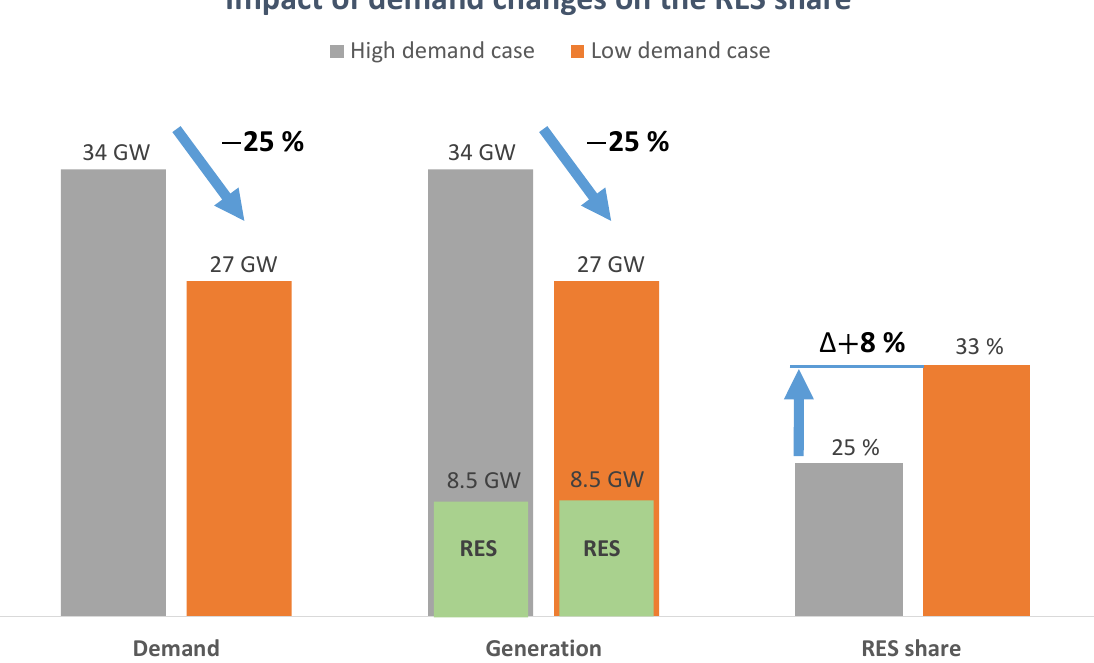
Figure 7. An illustrative example of the impact of demand changes on the renewable energy sources (RES) share for typical UK RES conditions. The RES share grows under the assumption of constant RES output before and after the demand changes. The RES shares are kept constant in order to point out the impact of a